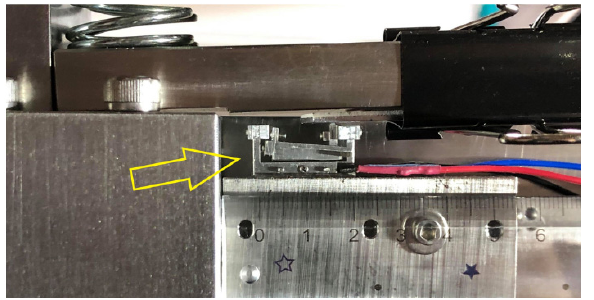
Figure 26. A prototype of the compact model in the measurement position in the setup of Figure 16.